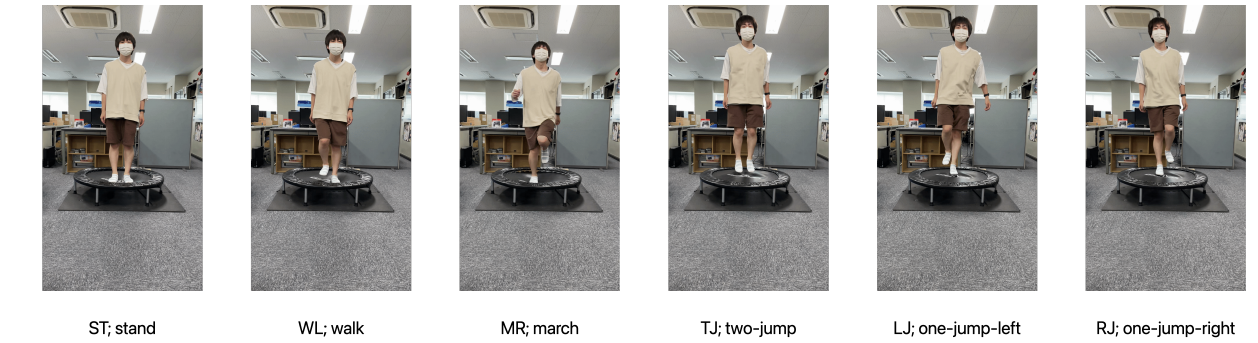
Figure 4. Six types of motions on the trampoline to be recognized by our method. ST is the staying behavior where the user stands and stops on the trampoline. WK is the walking behavior where the user stomps his/her feet on the trampoline. MR is also the walking behavior where the user stomps his/her feet while jumping lightly on the trampoline. TJ is the jumping behavior where the user jumps on the trampoline with both feet. LJ is also the jumping behavior where the user raises his/her right leg and jumps on the trampoline with his/her left leg. RJ is the opposite of LJ, the jumping behavior where the user raises his/her left leg and jumps on the trampoline with his/her right leg.